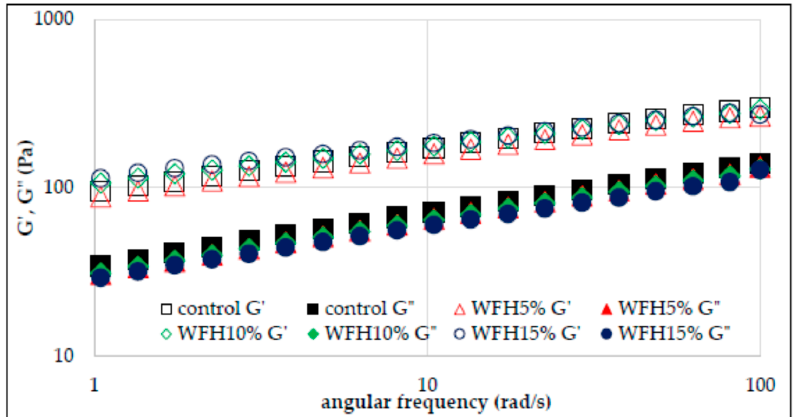
Molecules 2021 , 26 , x FOR PEER REVIEW Figure 3. Sweep frequency curves of wheat flour gel and samples with hazelnuts addition.